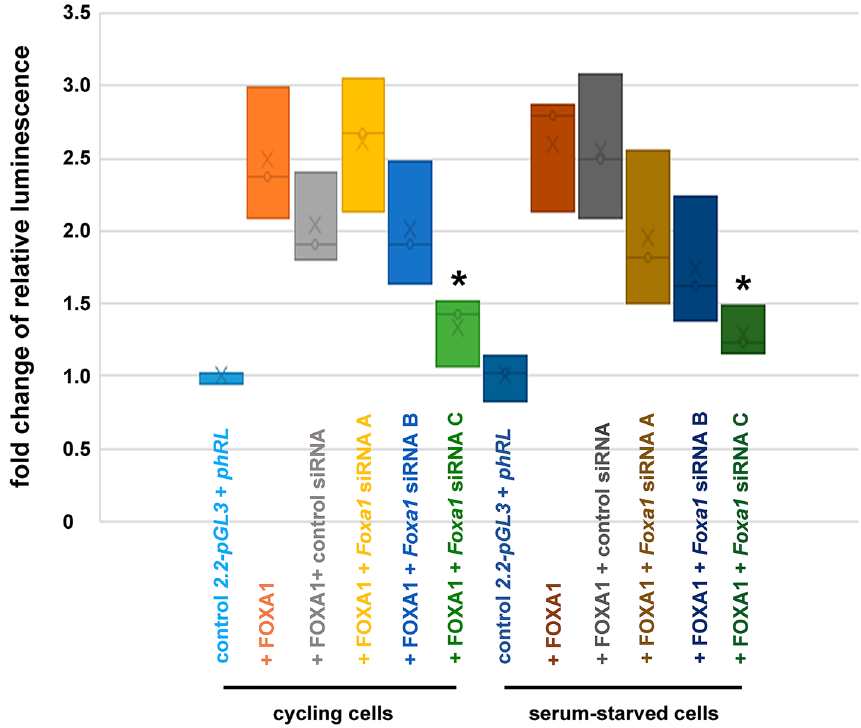
Figure 3. siRNA-mediated knockdown of Foxa1 inhibits FOXA1-mediated activation of the Odf2 promoter. Overexpression of FOXA1 (+ FOXA1) induced transcriptional upregulation of the firefly luciferase reporter controlled by the Odf2 promoter ( 2.2-pGL3 ) compared to the control ( 2.2-pGL3 + phRL ) in both cycling cells and serum-starved cells. Co-transfection of the scrambled non-target siRNA (+ FOXA1 + control siRNA) did not significantly change the activity of the firefly luciferase. Co-transfection of either one of the three Foxa1 siRNA duplexes (+ FOXA1 + Foxa1 siRNA A, B, or C, respectively) repressed activation of the reporter vector in both cycling cells and serum-starved cells. Significant transcriptional repression by Foxa1 siRNA C (in cycling cells: p = 0.039532*, in serum-starved cells: p = 0.014283*, Student’s T-test, two-tailed, homoscedastic). Three biological replicates